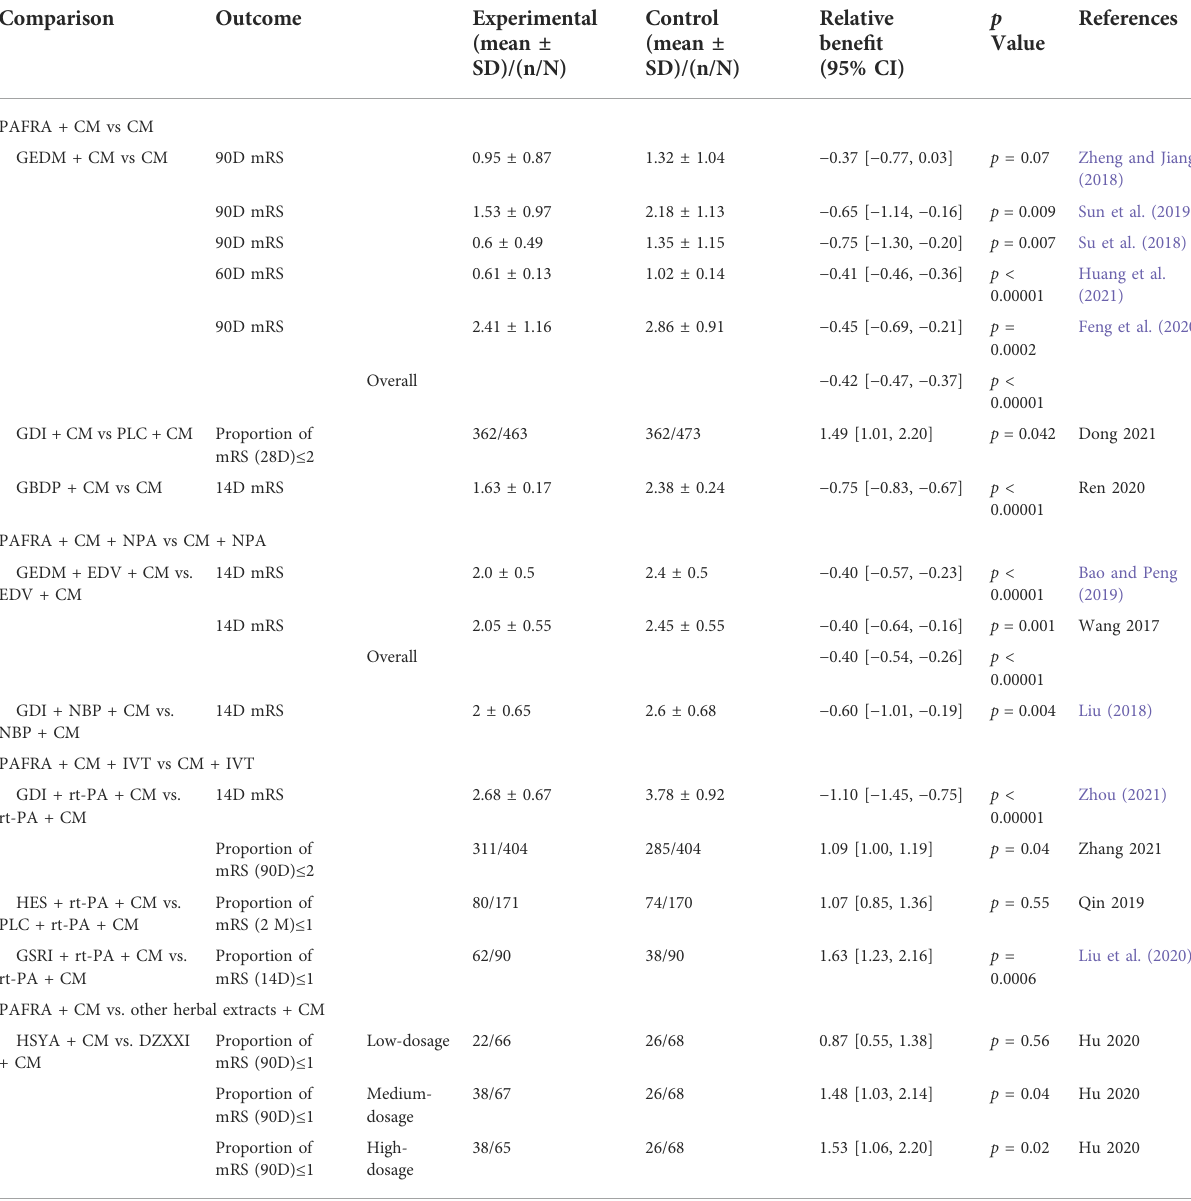
TABLE 2 Effect of platelet-activating factor antagonists on mRS in acute ischemic stroke.